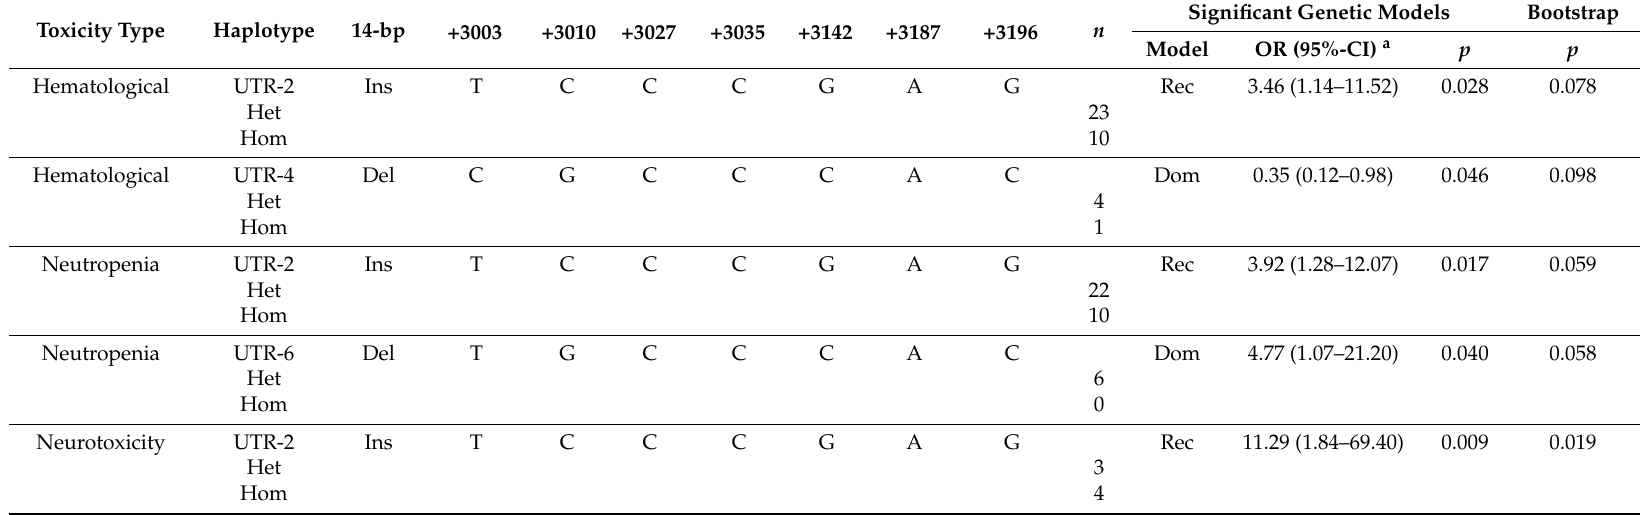
Table 6. Significant associations between HLA-G 3 (cid:48) UTR haplotypes and G3-4